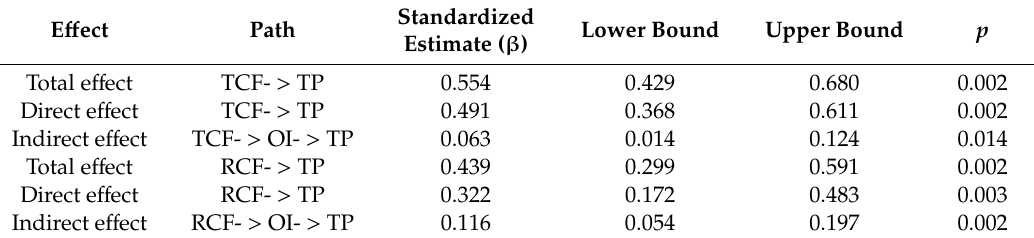
Table 6. Mediating effects of organizational identification.